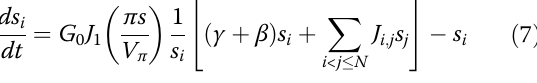
oscillation network can be expressed as Eq. (11). To solve the Ising problem with the given matrix J , the interactions between the spins are fi rstly programmed into the oscillation network, either in the analog or in the digital domain. And then, the cavity gain is increased gradually to search for the minimum-loss state. Meanwhile, the amplitudes of spins increase, and their phases are adjusted towards the lowest con fi guration. When the oscillation network runs stably, one can measure the corresponding phase con fi guration, from which the best answer to the given problems can be solved. However, the assumption that all the spins have the same amplitude is not always satis fi ed. When solving complex problems, the spins experience different inter- actions along the optoelectronic cavity, which would change the spin gain and ultimately results in amplitude non-uniformity. This non-uniformity may cause incon- sistency between the minimal-loss con fi guration and the optimal solution to the corresponding problem. The negative impact of nonuniformity also can be found in the DOPO-based Ising machine 49 . Fortunately, limiting the amplitude of spins at the feedback and optimizing the nonlinear function could reduce the amplitude inhomo- geneity to improve the success probability 43,44 . Details about how the nonuniformity impedes the machine from fi nding the best answer and how to relieve such negative impact are under